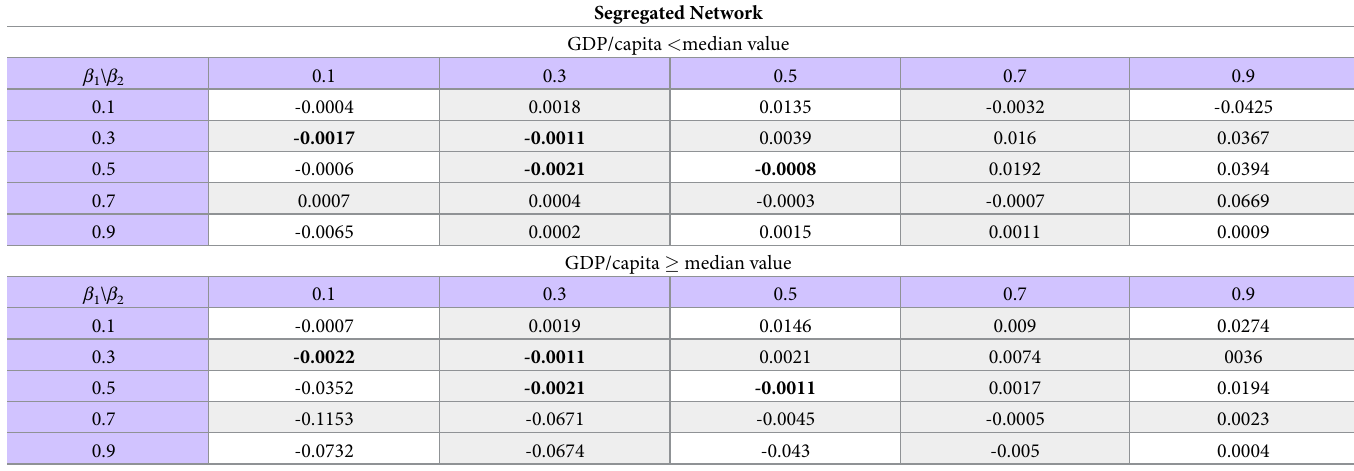
Table 1. This set of tables document the coefficients of linear regressions of numerical Δ s as a function of the Gini coefficient G , for different choices of parameters: ¼ 0 : 5 , � y ¼ 4 , σ = 1. For each combination of parameters, several independent simulations are per- β 1 , β 2 and λ = 0.01 (segregated network). We fix as constants: � c 0 formed, during which the time evolution of Δ t is calculated and then averaged, conditioned to a crisis, i.e. either δ c 90 < 0 or δ c 10 < 0. We further distinguish between coun- tries having a GDP/cap. higher and lower than the median value of the available data. The reference value of the regression for empirical data is -0.0018 if GDP/capita < median value and -0.0017 otherwise.